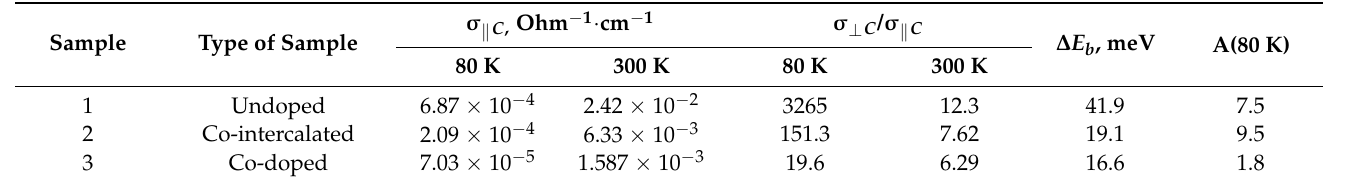
perature for as-grown pristine (1), Co-intercalated (2), and Co-doped (3) crystals of n -type InSe.